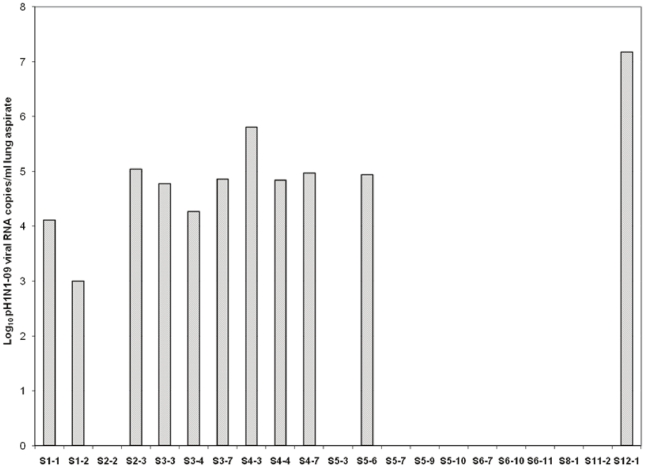
Virus titres in the lung aspirates of critically ill patients.RNA log10 copies/ml were determined by HA gene based real-time PCR assay. Y-axis represents different patients and samples obtained days post admission of the sequential samples of respective patients (S1-1, S1-2, …and S12-1).